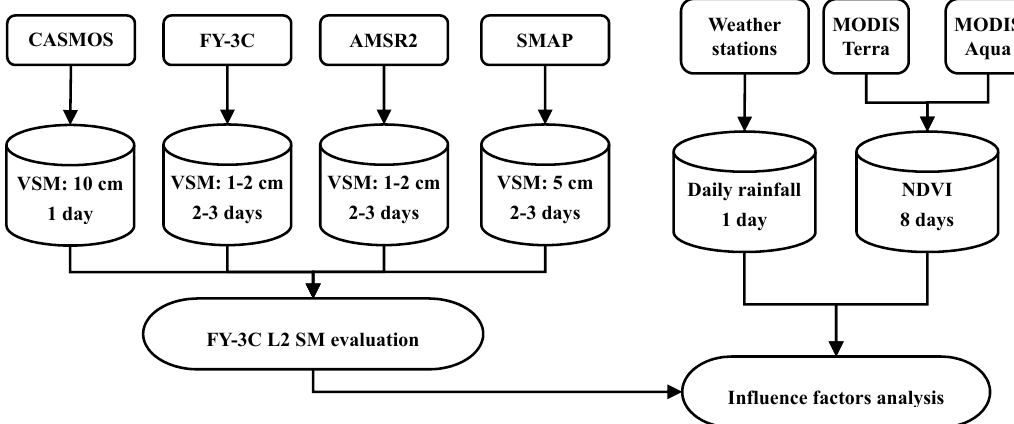
Figure 4. Work flowchart of this study. CASMOS represents the Chinese Automatic Soil Moisture Observation Stations deployed in the study area; Fengyun-3C (FY-3C), Advanced Microwave Scanning Radiometer 2 (AMSR2), and Soil Moisture Active/Passive (SMAP) represent the corresponding soil moisture products derived from the satellites; and VSM indicates the volumetric soil moisture with the unit in m 3 /m 3 .